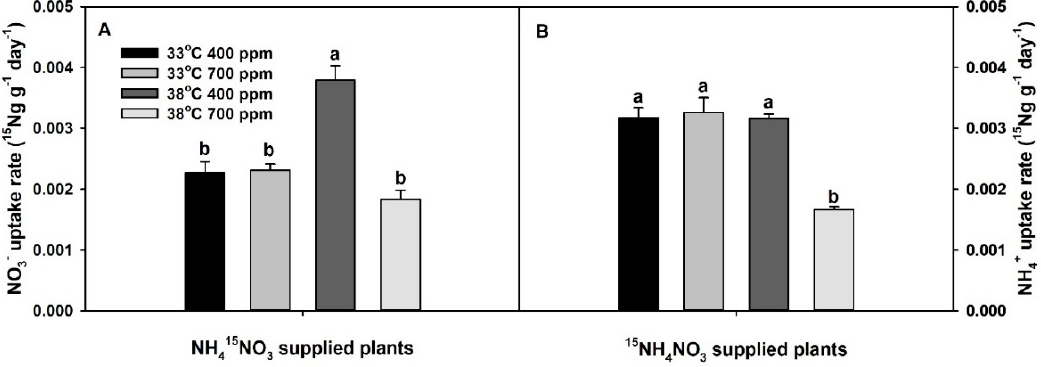
Figure 2. Effects of ambient (400 ppm) vs. elevated (700 ppm) CO 2 and near-optimal (33 ◦ C) vs. chronic warming (38 ◦ C) day-time temperatures on ( A ) NO 3 − uptake rate ( 15 Ng g − 1 day − 1 ) and (B) NH 4+ uptake rate ( 15 Ng g − 1 day − 1 ) of Solanum lycopersicum labeled for 3 days with 1 mM ( A ) NH 415 NO 3 or ( B ) 15 NH 4 NO 3 and grown for 21 or 23 days, respectively. Each bar represents mean (n = 5) + 1 SEM. Within each panel, bars not sharing the same letters are significantly different ( p < 0.05, Tukey’s test).